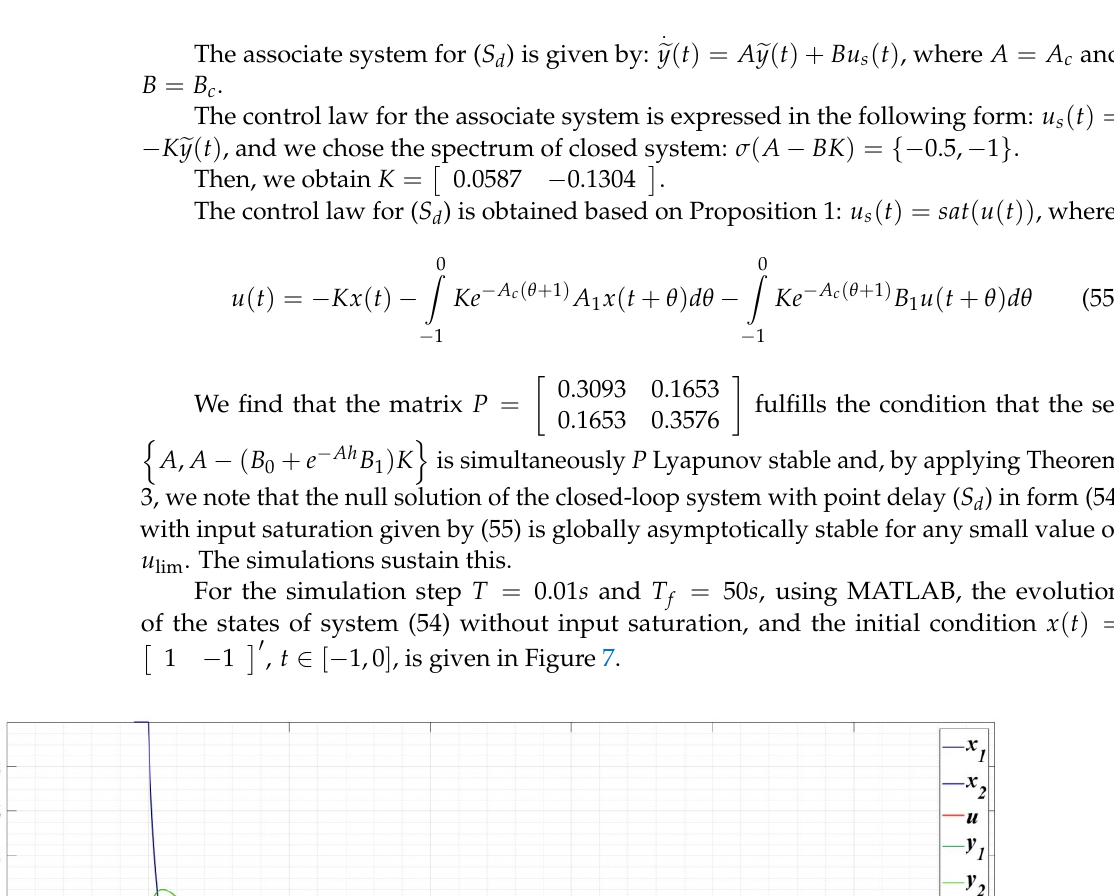
Figure 8. Evolution of the states with 06.0 Figure 9. Evolution of the states with 01.0 ≤ u .